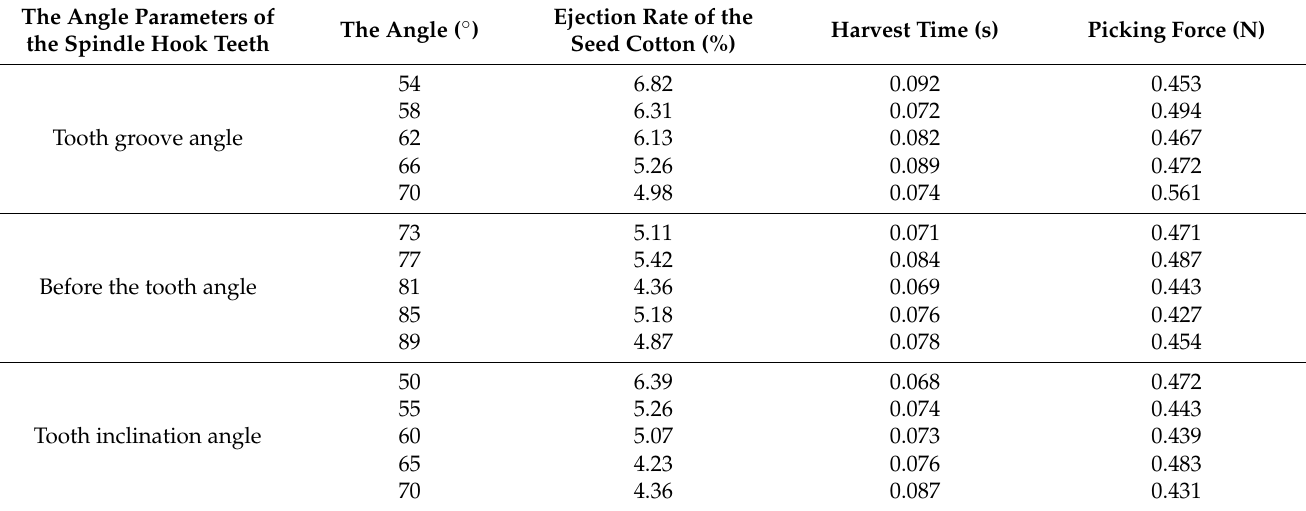
Table 2. The performance results of the spindle with various angle parameters of the hook teeth.